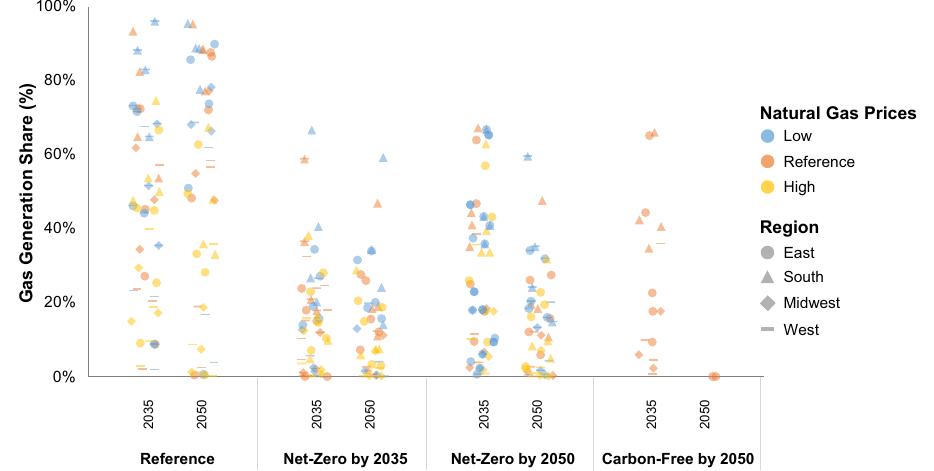
Fig. 4 | Regionalgeneration sharesbypolicy scenario in 2035and 2050. Shares include natural-gas- fi red generators with and without carbon capture as well as hydrogen through steam methane reforming. Natural gas price sensitivities are